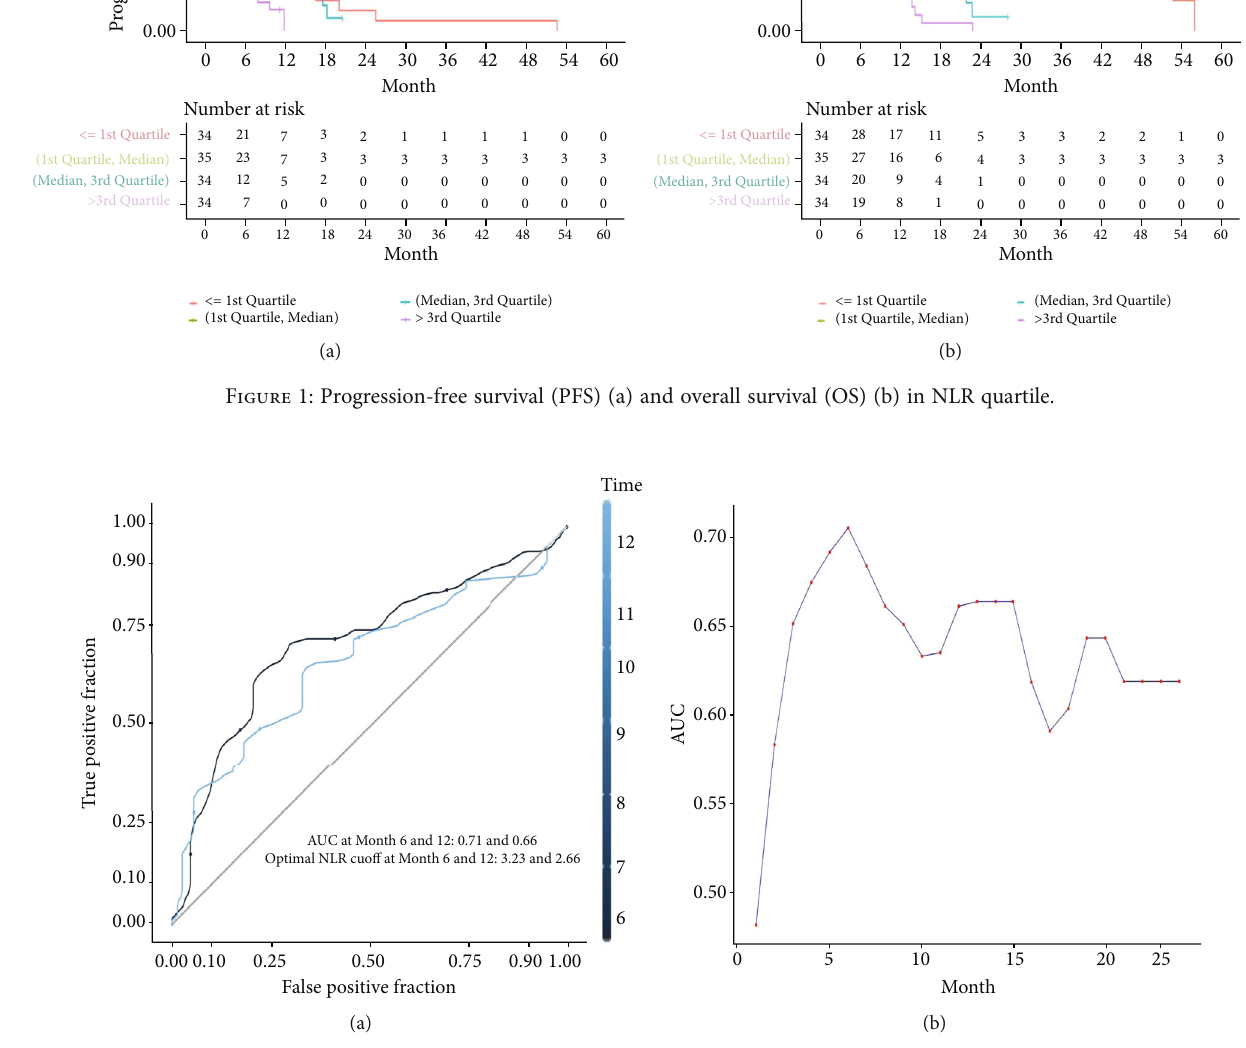
Figure 2: (a) Receiver operating characteristic curves for predicting 6-month and 12-month PFS by the neutrophil-to-lymphocyte ratio (AUC areas under the curve are 0.71 and 0.66). (b) AUC value by PFS